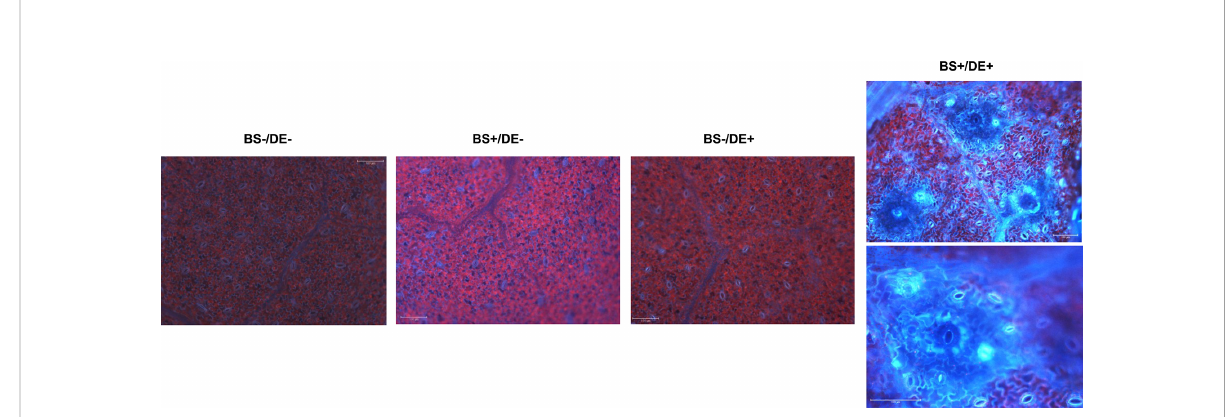
FIGURE 8 Observation of grapevine leaves by epi fl uorescence microscopy. Micro-cuttings were transplanted in a solid medium supplemented by BS 0.1% (v/v, “ BS+ ” ) or water ( “ BS- ” , as control). At 4 wpt, they were divided into two sets: one treated by immersion in a defense elicitor solution (DE+) and the other one in water as control (DE-). Two days later, leaves were detached from plantlets and their lower side was observed by fl uorescence microscopy. Bars represents 100 m m.